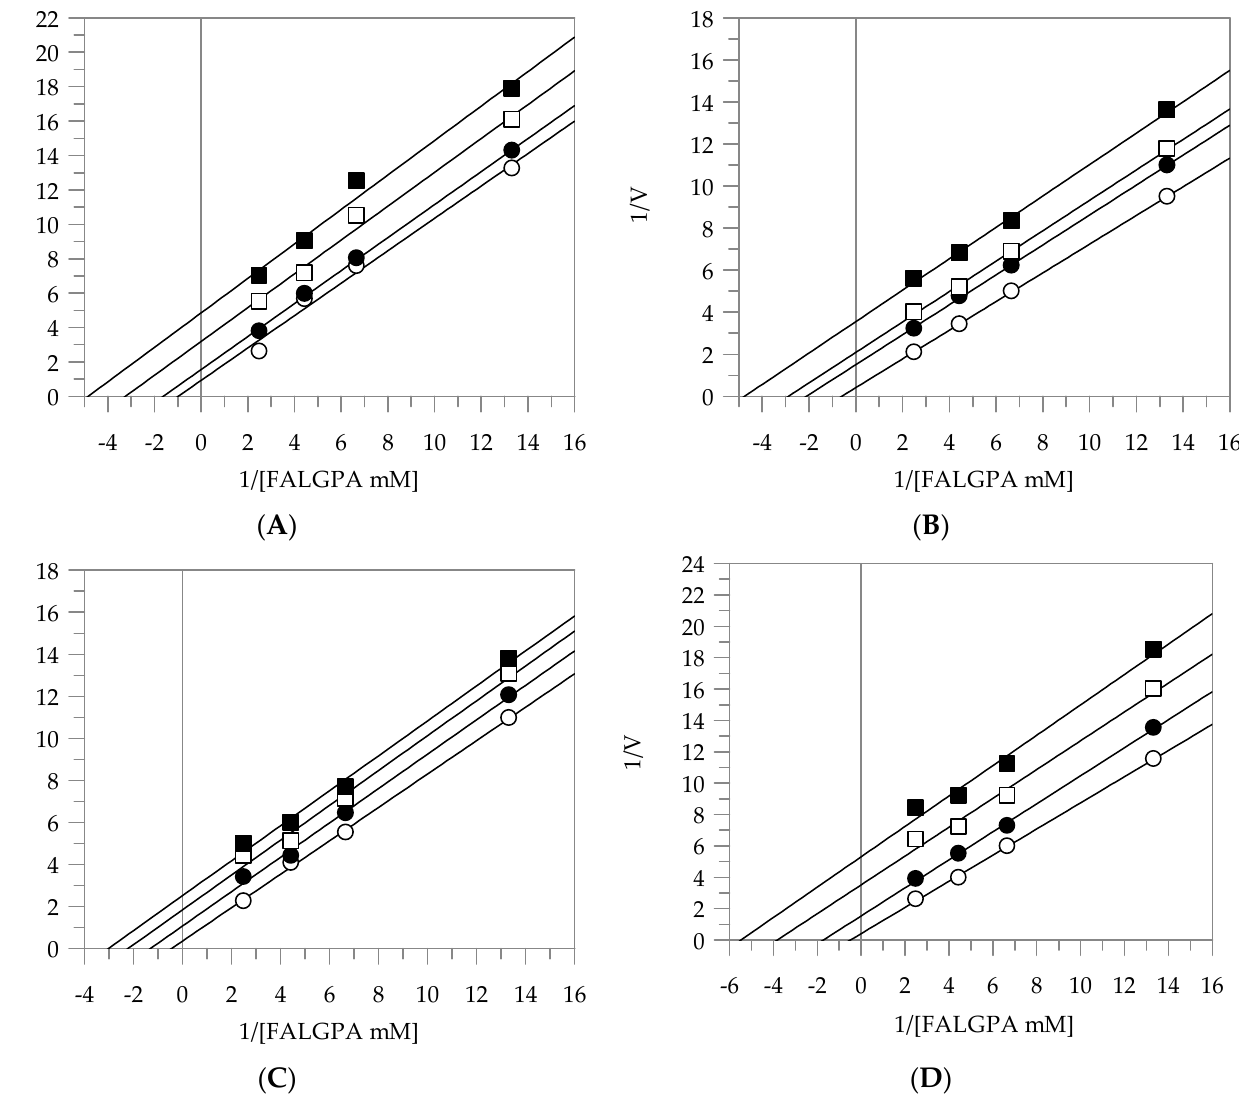
Figure 3. Inhibition of collagenase activity, using N-(3-[2-Furyl]-acryloyl)-Leu-Gly-Pro-Ala (FALGPA) as a substrate. Lineweaver–Burk plots analysis of EEG ( A ), EES ( B ), MEG ( C ), and MES ( D ). Reaction conditions are reported in Section 3. EEG and EES concentrations were 0